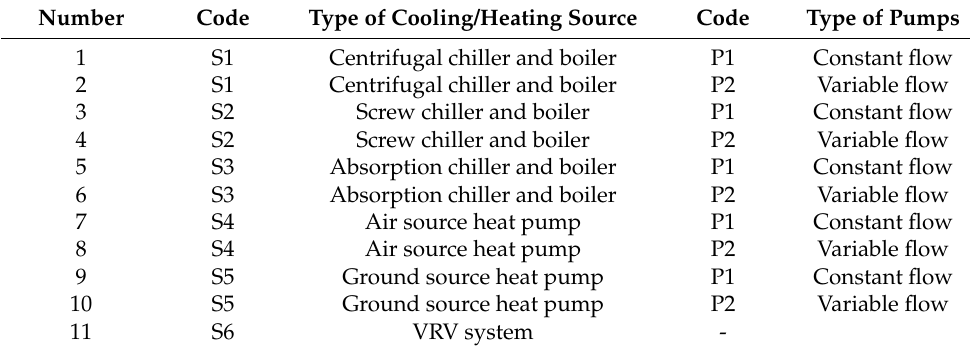
Table 3. Codes to refer to 11 types of HVAC system as the optional design